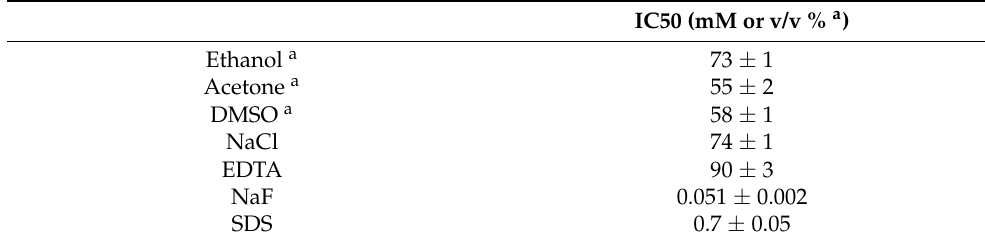
Table 6. Inhibition (IC50 assay) of purified DM laccase by different